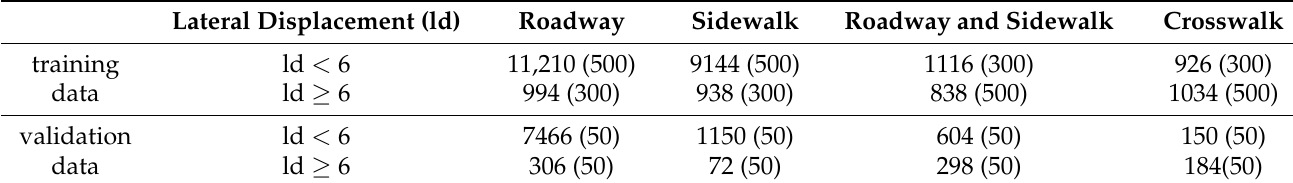
Table 2. The number of automatically labeled images including horizontally flipped images. The numbers in parentheses are the number of images used for training and validation, respectively, which were generated using data collected in different